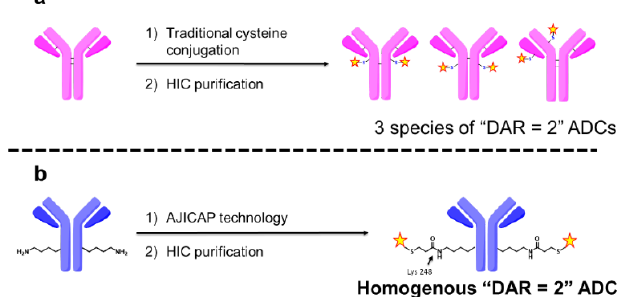
Figure 1. Comparison of two different antibody drug conjugates (ADC) synthetic methods that include conjugation and preparative hydrophobic interaction chromatography (HIC) purification: ( a ) Traditional cysteine conjugation approach and ( b ) AJICAP™ approach.